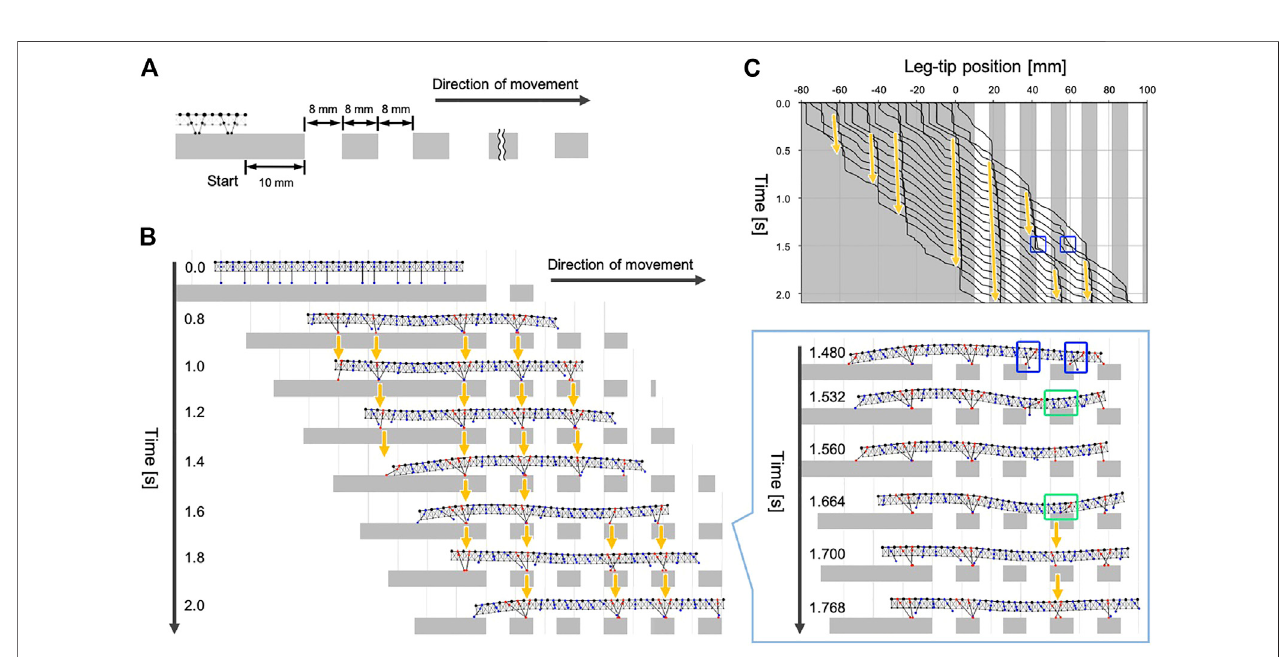
FIGURE 6 | Simulation results for walking on terrain with evenly spaced gaps. (A) Schematic of the experimental setup. (B) Snapshots of the simulated walking using the proposed model. (C) Spatiotemporal plots of the leg-tip positions. Orange arrows denote the ground contact points of the anterior legs were trailed by their neighboring posterior legs. Blue squares indicate the legs missed the footing. Green square indicates the body section where the ventral surface touched the ground.